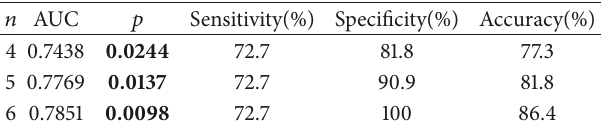
Table 3: Classification analysis results for mPE in terms of highest AUC, including sensitivity, specificity, and accuracy, and their significance 𝑝 . 𝑛